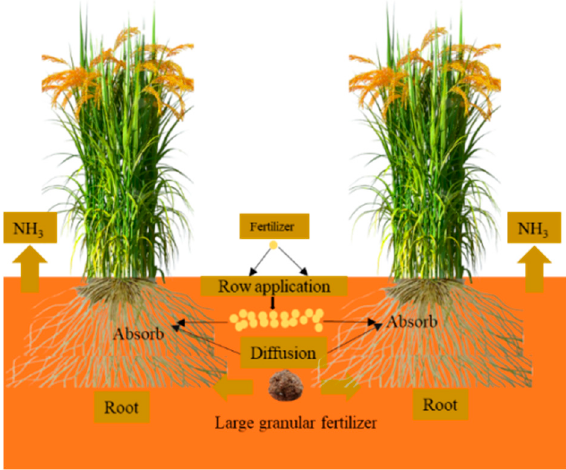
Figure 1. Schematic diagram of potted plants.